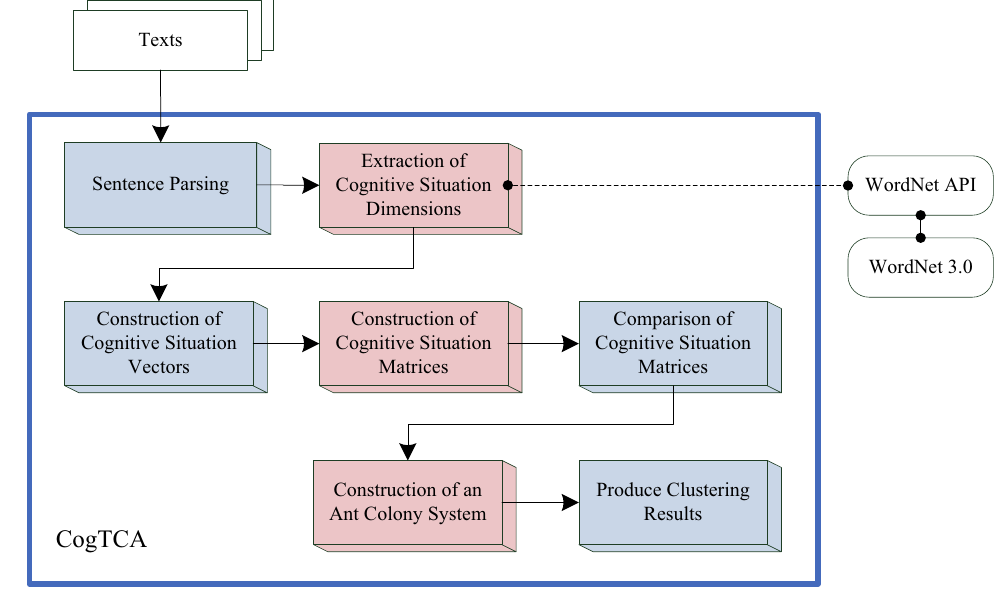
Fig.3. Structure of